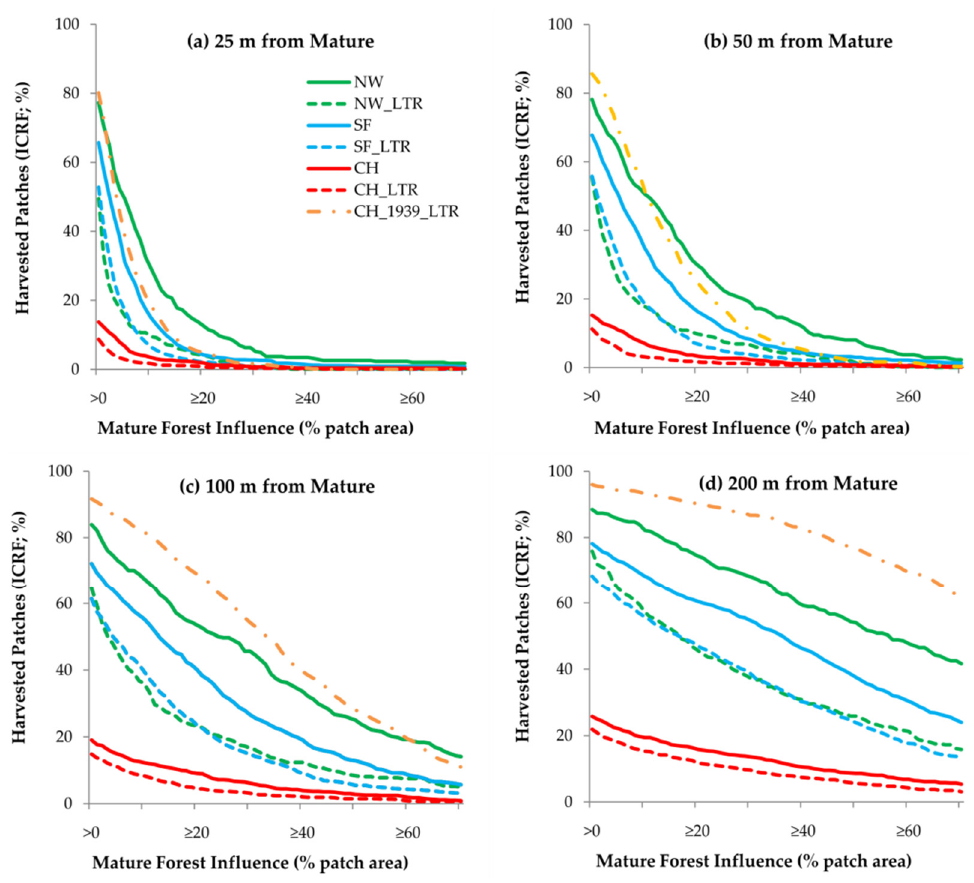
Figure 4. Inverse cumulative relative frequency (ICRF; %) of harvested patches at different levels of mature forest influence for three study areas (Southern Forests Tasmania (SF); North West Tasmania (NW); Central Highlands Victoria (CH)). Mature forest influence is the proportion of harvested patch area within a particular distance of structurally mature forest distance: ( a ) 25 m; ( b ) 50 m; ( c ) 100 m; and ( d ) 200 m. ICRF curves were calculated for all mature forest patches (no suffix) and mature forest patches in long-term retention (_LTR). In Victoria, relationships were also generated for 1939 regrowth in long-term retention (CH_1939_LTR). For example: in ( a ), 19% of harvested patches in Southern Forests Tasmania had more than 10% of their patch area within 25 m of a mature forest patch.